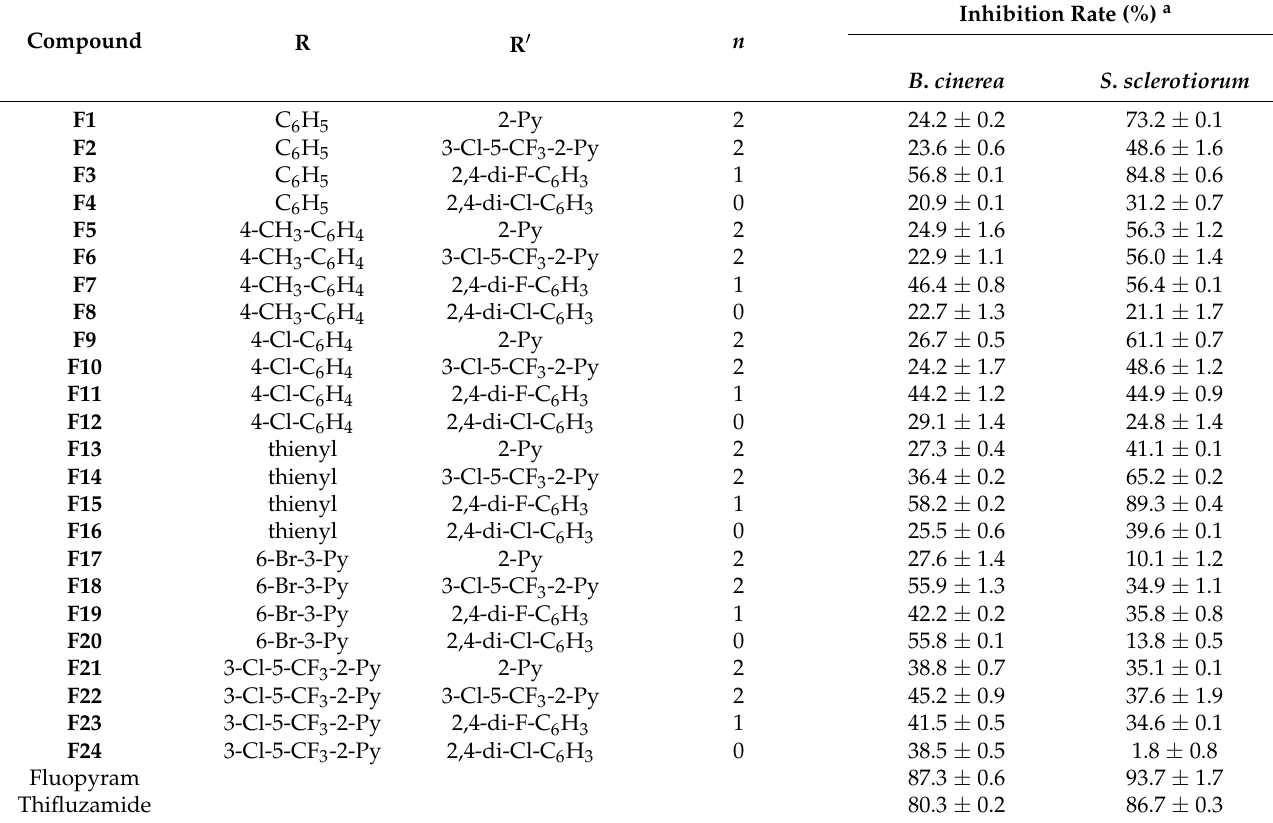
Table 1. In vitro antifungal activity of the title compounds F1 – F24 at 50 µ g/mL.